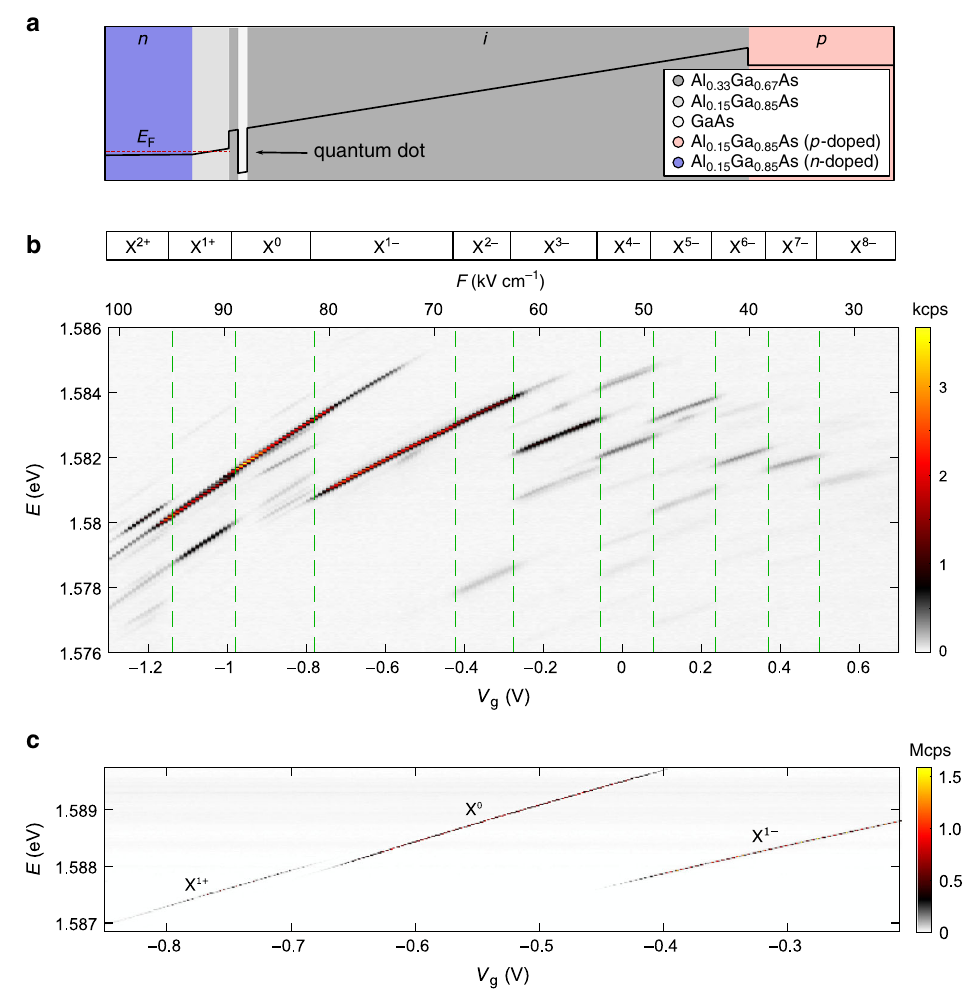
Fig. 1 Tuning the charge state of single GaAs quantum dots. a Schematic band structure (conduction band) of the diode hosting charge-tunable GaAs quantum dots. b The photoluminescence emitted by an exemplary single quantum dot as a function of the gate voltage, V g . (Positive gate voltage indicates a forward bias.) The corresponding electric fi eld, F , is plotted as an additional x -axis on top. The photoluminescence is resolved in energy by a spectrometer and measured on a CCD-camera. The emission spectrum shows several plateaus corresponding to different charge states of the quantum dot. We observe narrow photoluminescence-linewidths on highly charged excitons where up to eight additional electrons occupy the quantum dot. c Resonance fl uorescence from X 1 + , X 0 , and X 1 − charge plateaus measured on another quantum dot (QD1). X 1 + , X 0 , and X 1 − represent the positive trion, the neutral exciton, and the negative trion, respectively. The measurement is performed by sweeping the gate voltage for different laser frequencies. The resonance fl uorescence intensity is measured with a superconducting nanowire single-photon detector. This measurement is performed by resonant continuous-wave excitation below saturation. In saturation, the maximum count rate is 6.5 MHz (see Supplementary Fig. 1 for the power saturation